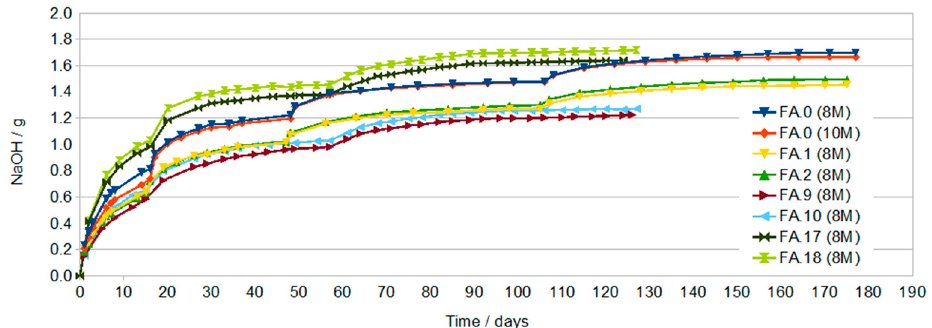
Figure 5 . Of NaOH washed out (in 250 cm 3 of solution).